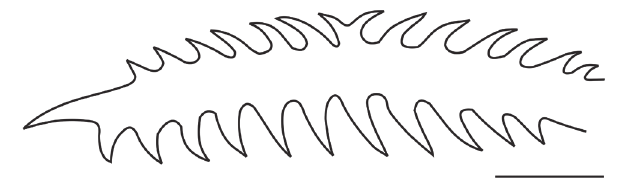
Fig. 2. Left pectoral-fin spine in dorsal view of paratype of Microglanis oliveirai , MZUEL 5175, 25.4 mm SL. Scale bar = 1